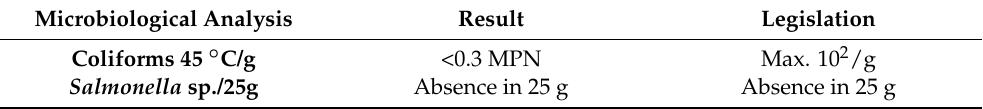
Table 6. Microbiological analysis of osmotically dehydrated sapodilla (assay 9). Microbiological Analysis Result Legislation Coliforms 45 ◦ C/g <0.3